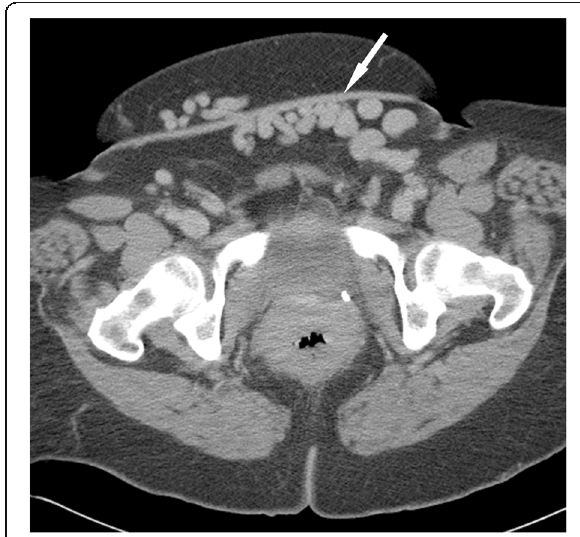
Fig. 4 Axial CT of a 55-year old woman presenting with bilateral lower extremity edema and pain. Torturous collaterals connecting the great saphenous veins are noted coursing through the anterior pelvic wall adipose tissue (white arrow)